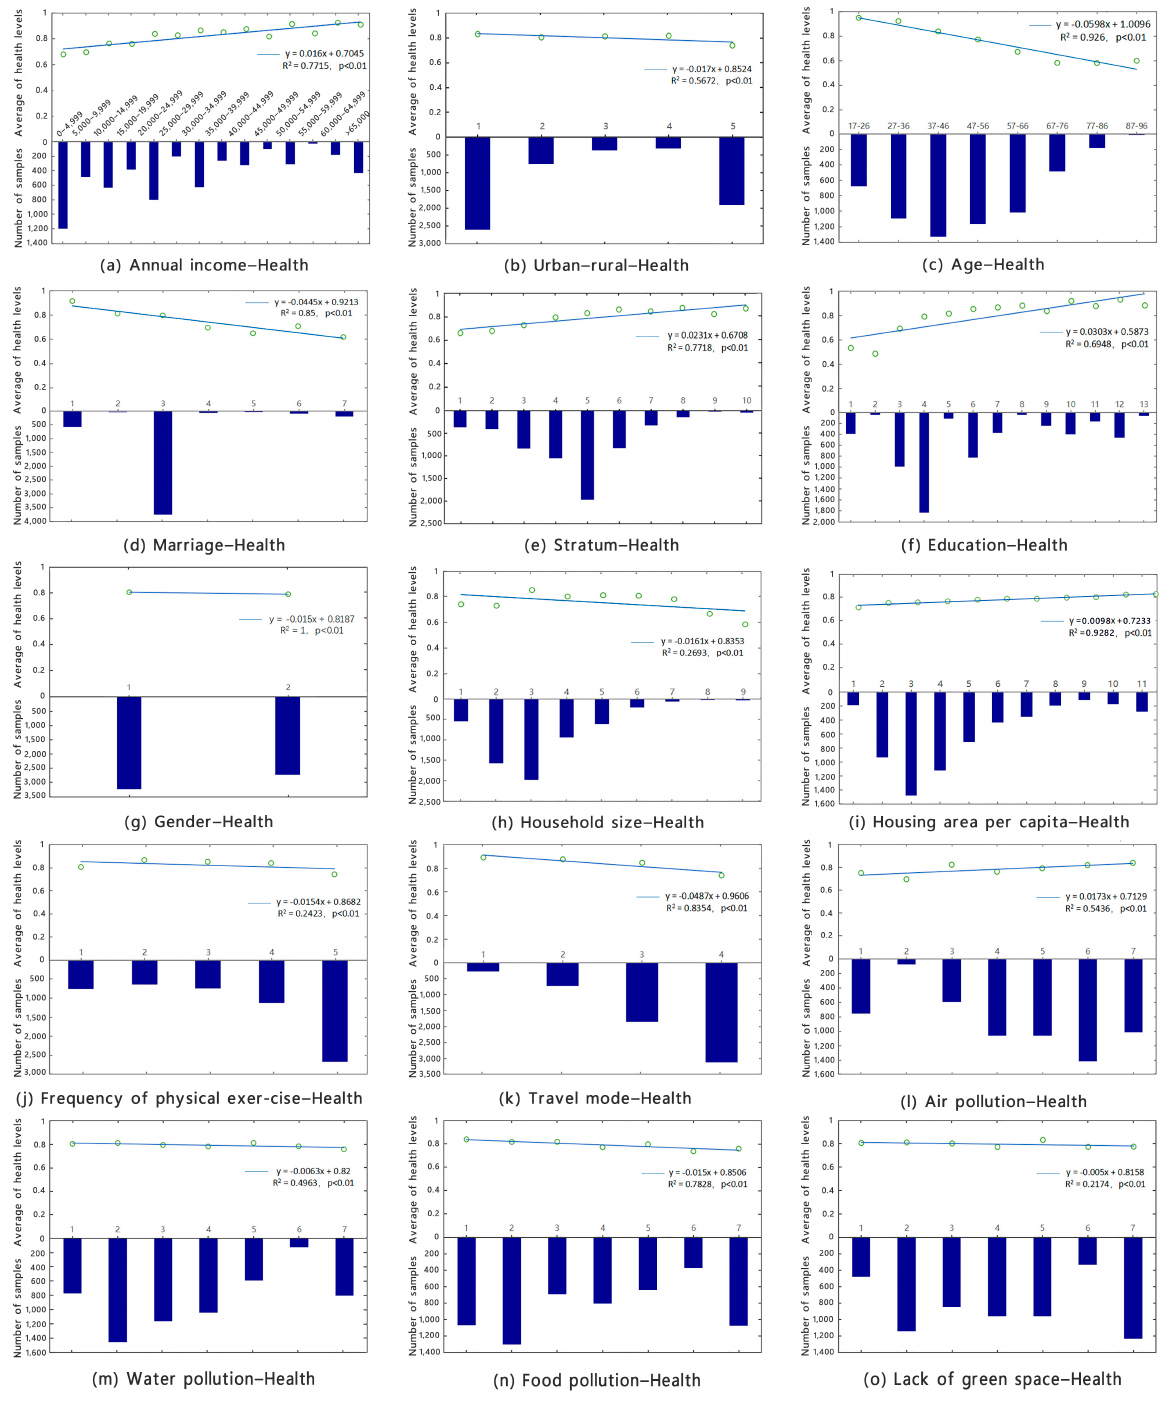
Figure 1. Coupling of variables with the health levels.